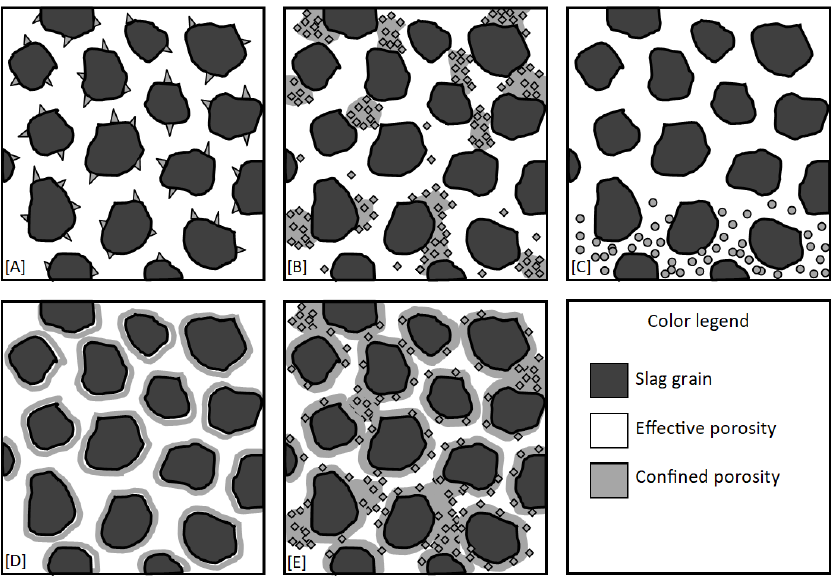
Figure 6. Types of clogging in steel slag filters and their effect on effective porosity. ( A ): Chemical precipitation with organized structure. ( B ): Chemical precipitation with disorganized structure, leading to the formation of confined zones. ( C ): Accumulation of nondegradable (inorganic or organic) suspended solids from the influent, (inlet at the bottom of the figure). ( D ): Formation of a biofilm on the slag grain surface. ( E ): Hypothesized combined effect of biofilm and disorganized crystal structure, leading to an increased formation of confined zones.